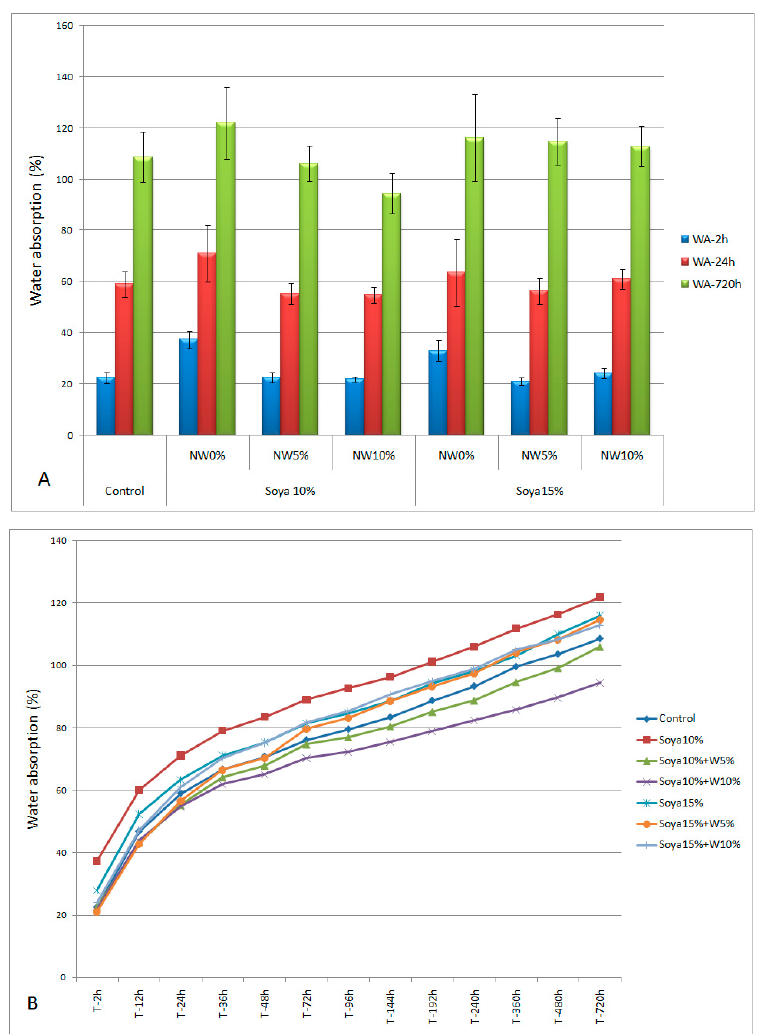
P 1 No. of delaminated cases after the first round of the soaking/drying cycle. 2 No. of delaminated cases after the third round of the soaking/drying cycle. 3 P = testing passed, F = testing failed. 4 Urea- Table 3. Delamination test on plywood produced with di ff erent binders and with the addition formaldehyde resin content. 5 Soy flour content. 6 Wollastonite content. of wollastonite. Substitution of soy flour for UF resin at both levels of 10% and 15% significantly increased the water absorption (WA) and thickness swelling (TS) (Figures 9A and 10A after 2, 24 and 720 hours Binder First Round 1 Third Round 2 Result 3 and Figures 9B and 10B at various time intervals). The increases were significant at 2 h, 24 h, and the long-term immersion of 720 h. The increase was attributed to the water hydrophilicity of soy UF 4 100% flour [38–41]. Addition of wollastonite (both W contents of 5% and 10%) to the resin mixture resulted in a significant decrease in water absorption, almost reaching the same value as in the control panels. This decrease was attributed to the reinforcing effect of wollastonite in the resin mixture. Similar reinforcing effects were previously reported to improve the shear strength of polyvinyl acetate resin [31] and the fire-retarding property of acrylic–latex paint [42]. With respect to thickness swelling, 5% wollastonite significantly decreased the TS to nearly the same level as in the control panels. However, TS values of panels containing 10% W were still nearly as high as the values of soy-treated panels. That is, a W content of 10% could not mitigate the negative effect of soy flour on thickness swelling. It was concluded that 10% wollastonite was too high, thereby absorbing UF resin rather than acting as reinforcing filler to improve thickness swelling; therefore, a W content of 5% is recommended as an optimum.